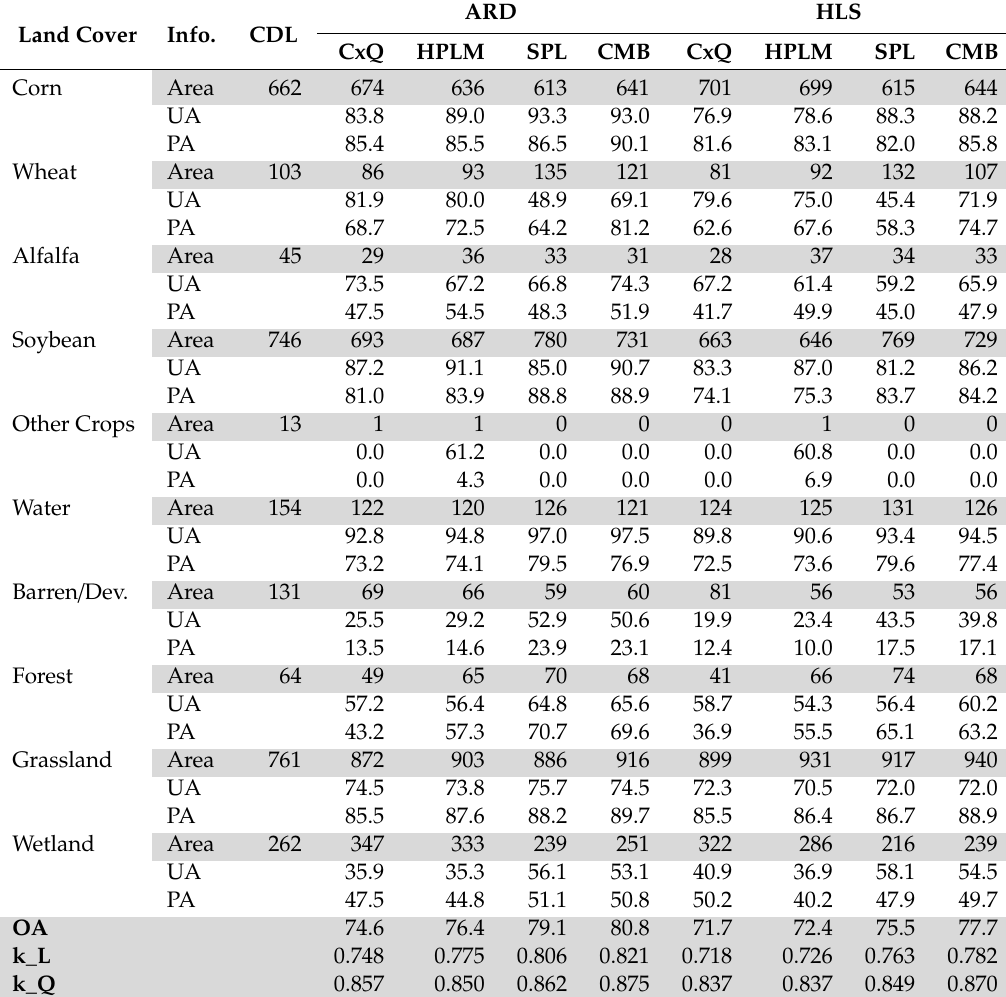
Table 12. Pixel-wise comparisons between 2016 predicted land cover maps and CDL, summarized by input variables. Land cover area is in km 2